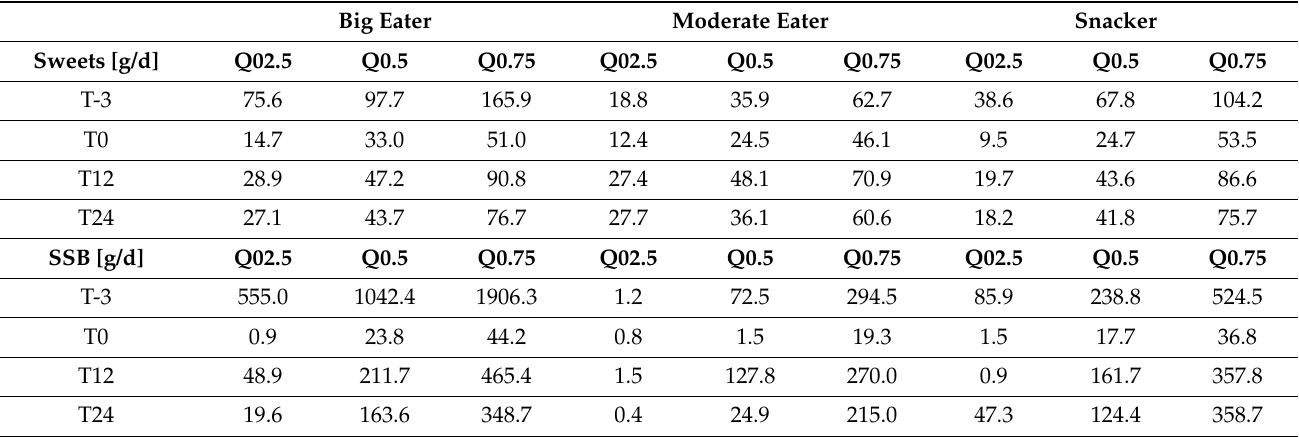
Table 2. Consumption of sweets and sugar-sweetened beverages (SSB) of the dietary patterns at enrollment (T-3), directly after inpatient rehabilitation (T0), and at follow-up (T12, T24). Big Eater Moderate Eater